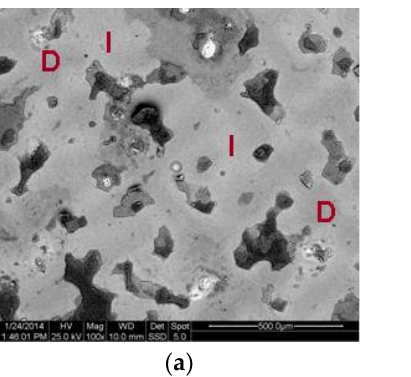
Figure 10. SEM backscattered electron images of alloy substrates (in contact with patina) after anodic polarization (OCP+ 1.5 V) in 0.1 mol/L NaCl solution: (a) of TB alloy (×100); (b) ZB (x50) (D: dendrite, I: interdendritic area).